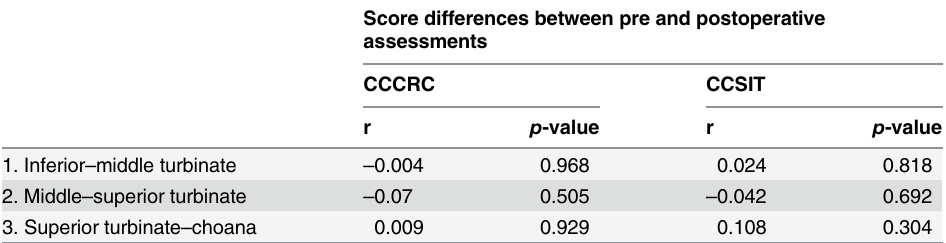
Table 3. Correlation between CCCRC, CCSIT and nasal cavity volume changes.